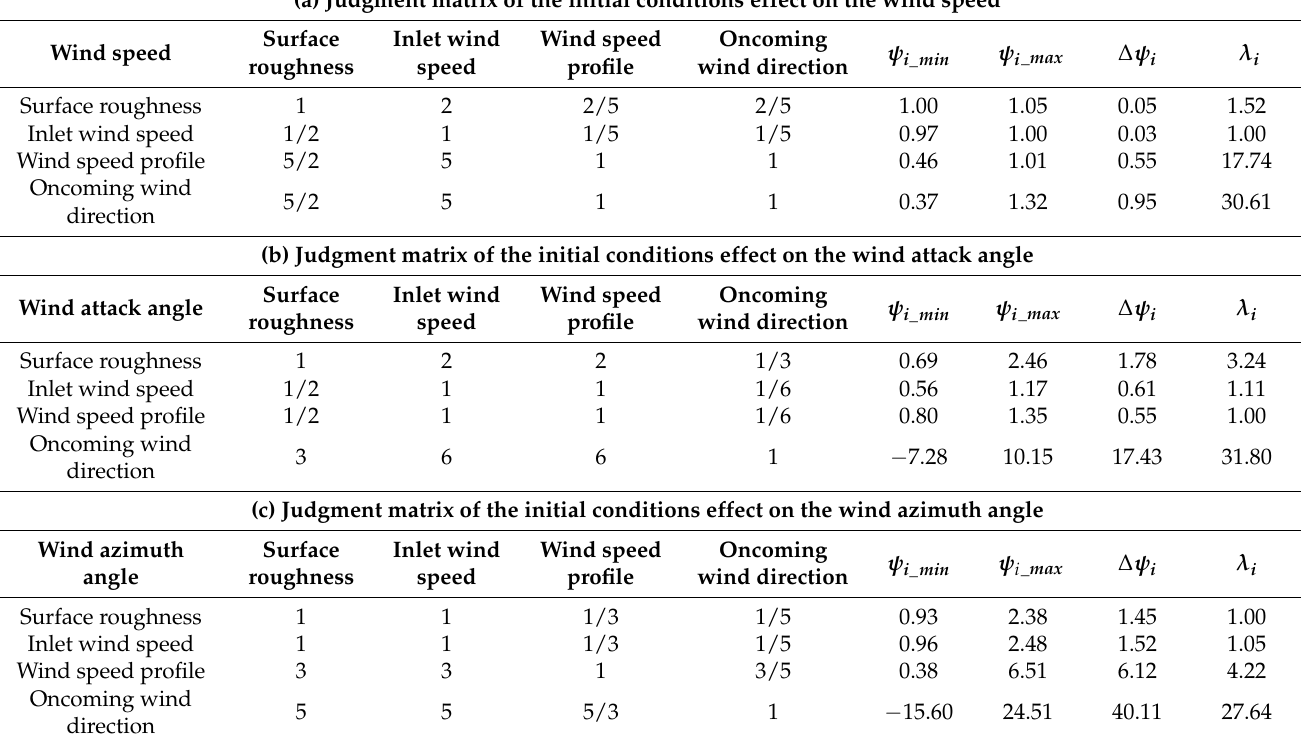
Table 5. Judgment matrix of the plan level.